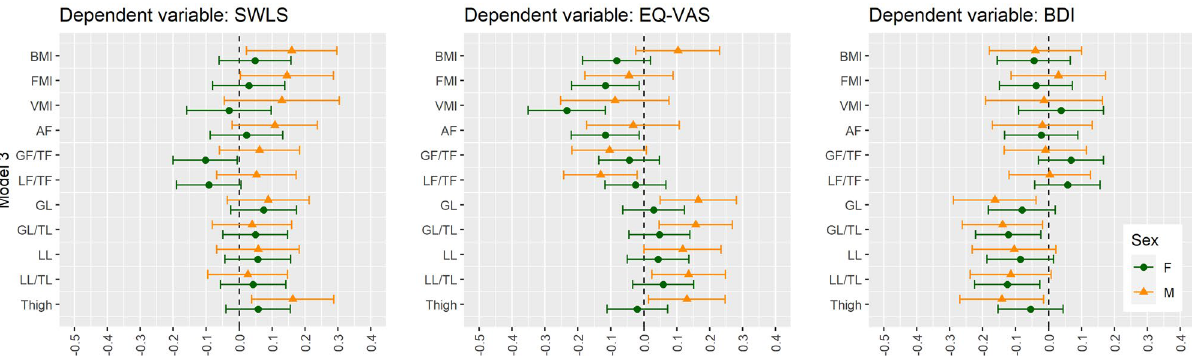
Figure 3. Multivariable linear regression analysis adjusted for age and WHR (Model 3) between body composition and subjective well-being scores in non-obese women and men. SWLS Satisfaction with Life Scale, EQ-VAS Euro Quality of Life Visual Analogue Scale, BDI Beck Depression Inventory, BMI Body Mass Index, FMI Fat Mass Index, VMI Visceral Mass Index, AF android fat, GF/TF gynoid fat/total fat, LF/TF legs fat/total fat, GL gynoid lean, GL/TL gynoid lean/total lean, LL legs lean, LL/TL legs lean/total lean, F female, M male. Model 3: adjusted for age and